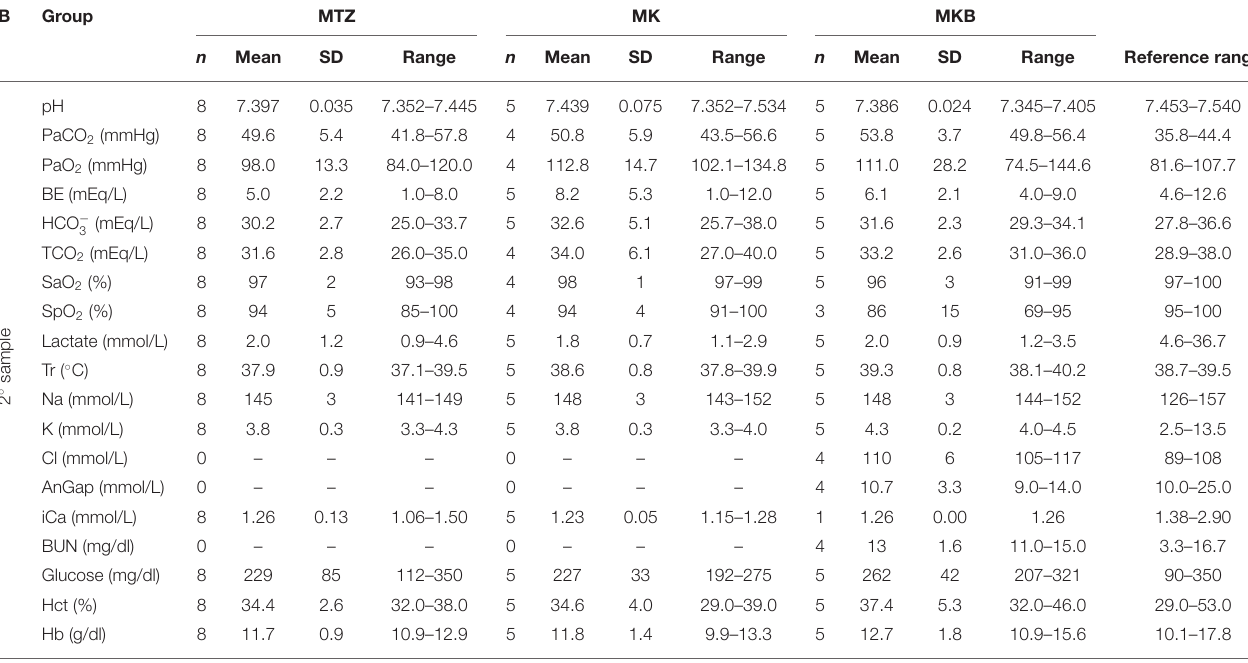
TABLE 4B | Blood gas, hematological and serum biochemistry variables after oxygen supplementation in 20 anesthetized wild boars. B